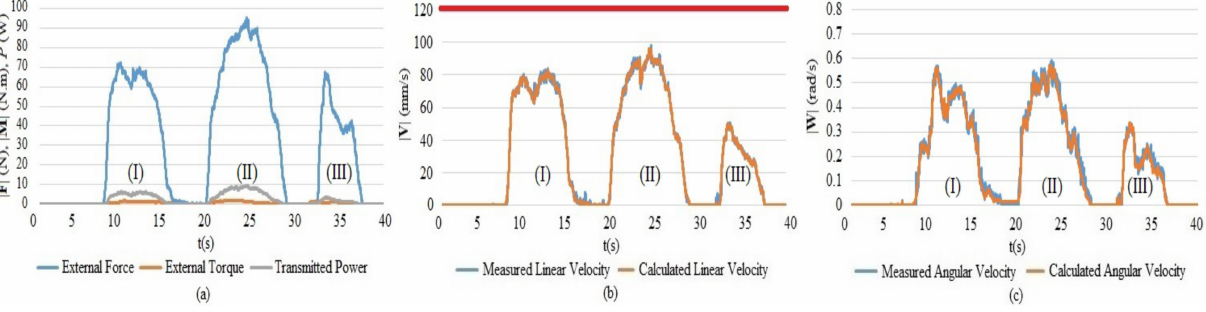
Figure 11. Experimental results using Bi-HA-based admittance controller, ( a ) presents the inputs | F | (N), | M | (Nm) and P (W); ( b ) and ( c ) present outputs | V | (mm/s) and | W | (rad/s),